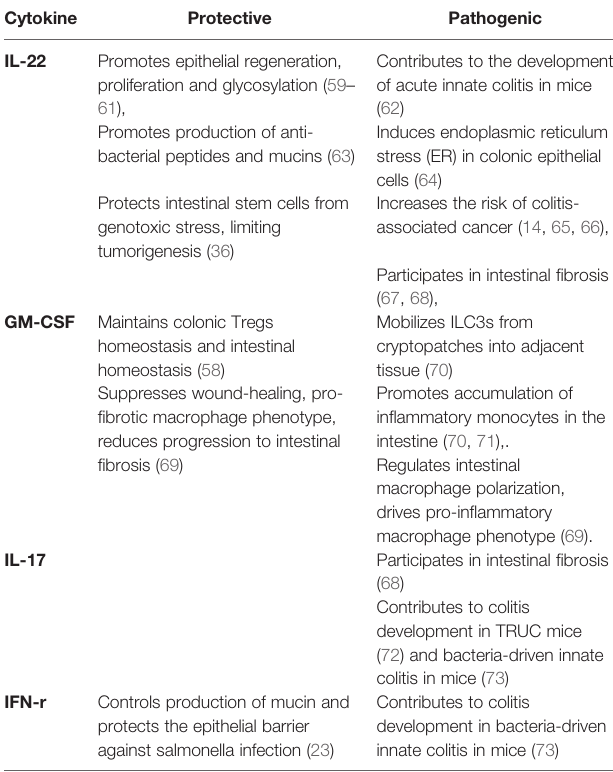
TABLE 2 | The dichotomous role of ILC3-derived cytokines in the intestinal immune response. Cytokine